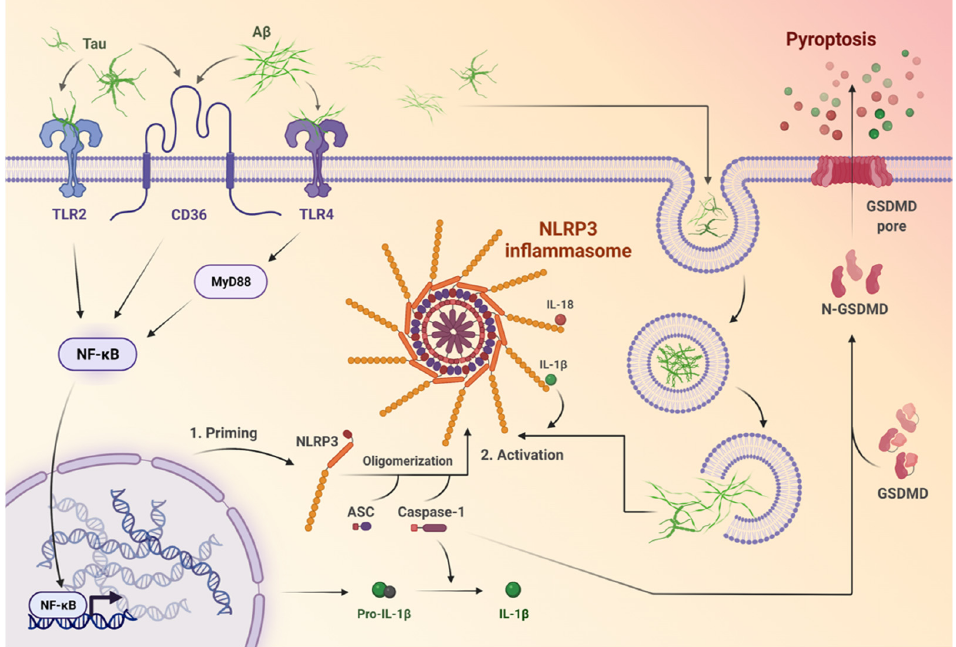
Figure 1. The mechanisms of priming and activation of the NOD-like receptor pyrin domain- containing 3 (NLRP3) inflammasome. Firstly, protein aggregates (A β and tau) are recognized by microglial pattern recognition receptors, such as Toll-like receptors (e.g., TLR2, TLR4), or cluster of differentiation 36 (CD36). Afterwards, they induce activation of specific pathways like MYD88/NF- κ B, which leads to transcription of pro-IL- β and NLRP3. One of the NLRP3 domains—the adaptor molecule apoptosis-associated speck-like protein containing a caspase recruitment domain (ASC)— recruits pro-caspase-1, which enables the release of inflammatory cytokines, namely IL-18 and IL- β . Further, cell death in the form of pyroptosis occurs after the activation of NLRP3 via the induction of gasdemin D (GSDMD). GSDMD can induce membrane-disrupting cytotoxicity and facilitates the secretion of inflammatory cytokines via the creation of pores in the cell